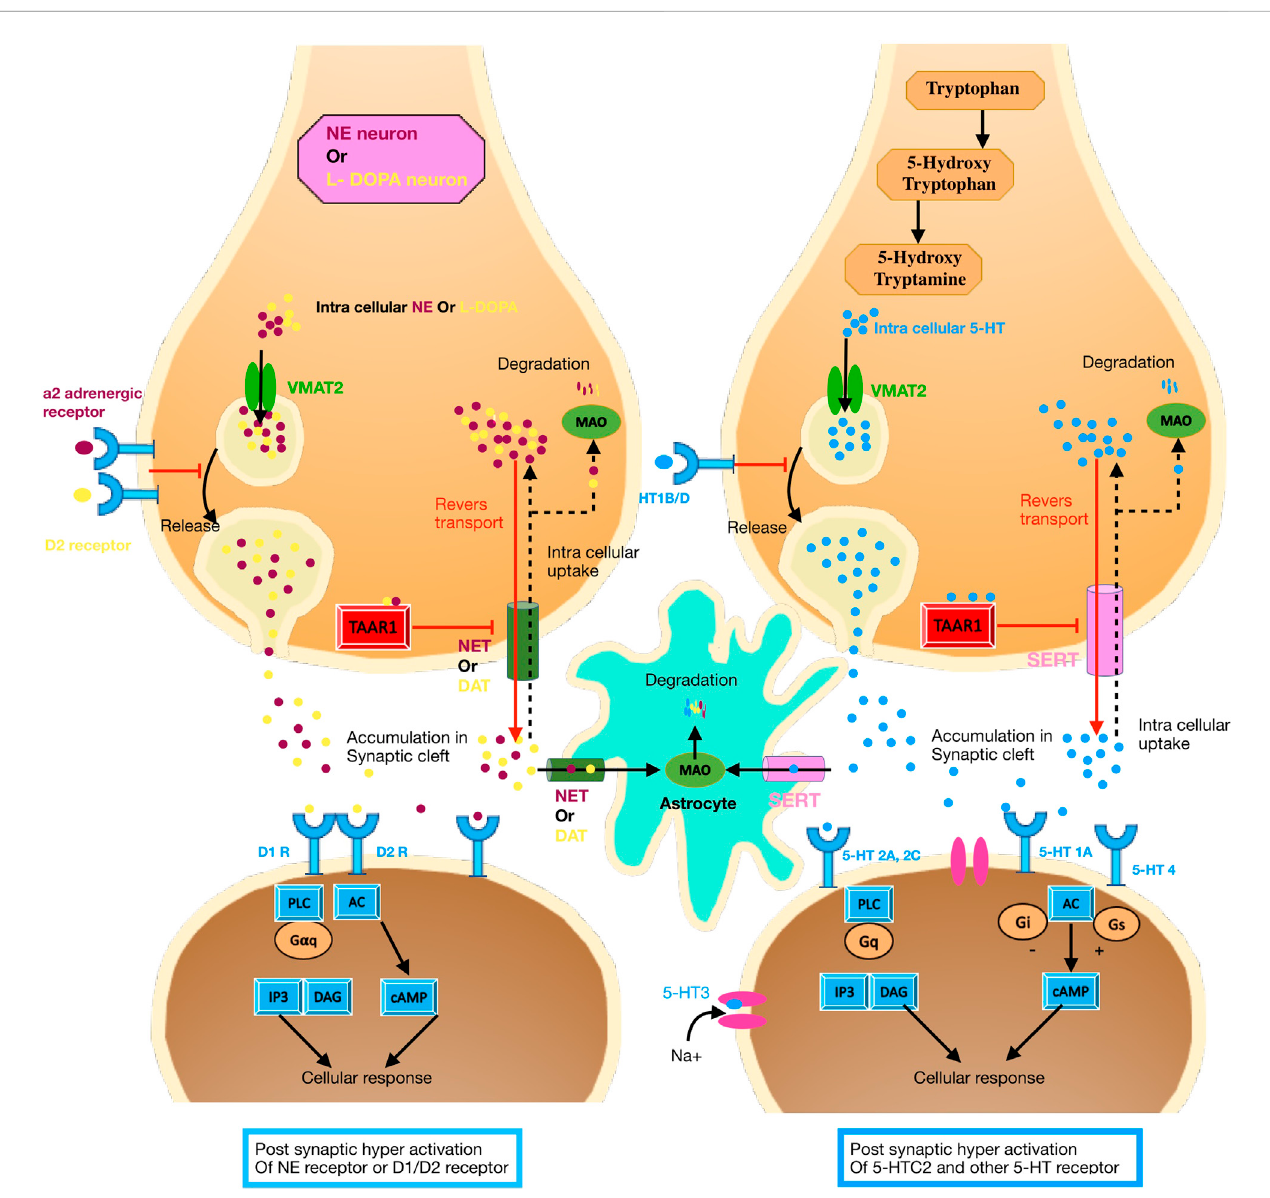
FIGURE 3 Serotonin-related signaling pathway; Dopamine and catecholamine-related signaling pathway. (A) Dopamine synthesis and signal transduction. The main metabolic pathway for dopamine synthesis has two steps. First, tyrosine hydroxylase can convert tyrosine to L-dopa and then L-dopa transforms to dopamine(notshown).Dopamineistransportedbythemonoaminetransporter(VMAT2)fromthecytosoltothevesiclesinsynapticvesiclesandisstoreduntil it is released into the synaptic cleft. Dopamine degradation pathway involves monoamine oxidase (MAO) in the outer mitochondrial membrane. Dopamine receptors are present in both postsynaptic and presynaptic neurons (including dopamine transporters, DAT). Dopamine receptors belong to the GPCRsuperfamilyassociated withvarioustypesofGproteins.D1-andd2-likereceptorsareimportantreceptorsfor dopaminesignaling.Thesereceptors are alsocrosstalkswithothersignalingpathwayssuchasG α q,G βγ ,DAG,IP3,CAMP,andMAPK-MEK-ERK. (B) 5-HTSynthesisandsignaltransduction.Tryptophan is the essential amino acid involved in the synthesis of 5-HT. In CNS l-tryptophan is hydroxylated to 5-hydroxytryptophan (5-HTP) by the enzyme tryptophan hydroxylase type 2 (TPH2). This is followed by subsequent decarboxylation THAT transforms 5-hydroxytryptophan into 5-hydroxytryptamine. 5-HT is transported by the monoamine transporter) VMAT2) into vesicles and storage. Like dopamine 5-HT can be degraded by monoamine oxidase (MAO) in the outer mitochondrial membrane. After released 5-HT it can engage with receptors. All 5-HTRs are heteroreceptors and postsynaptically expressed on non- serotonergicneuronsandautoreceptorslocatedpresynapticallyontheserotonergicneurons.5-HT1A,B,D,E,F,5-HT2A,B,C,5-HT4,5-HT5A,B,5-HT6,and 5-HT7 receptors are classi fi ed as G protein-coupled receptors (GPCRs), while 5-HT3A, B, C, D, E receptors are ligand-gated ion channels. Upon ligand binding,theintracellularloopandC-terminaltailinteractwithspeci fi cGproteinfamilies,includingG α s,G α i/o,G α q/11,andleadingtoactivatedmanysignaling pathways such as DAG, IP3, CAMP, and